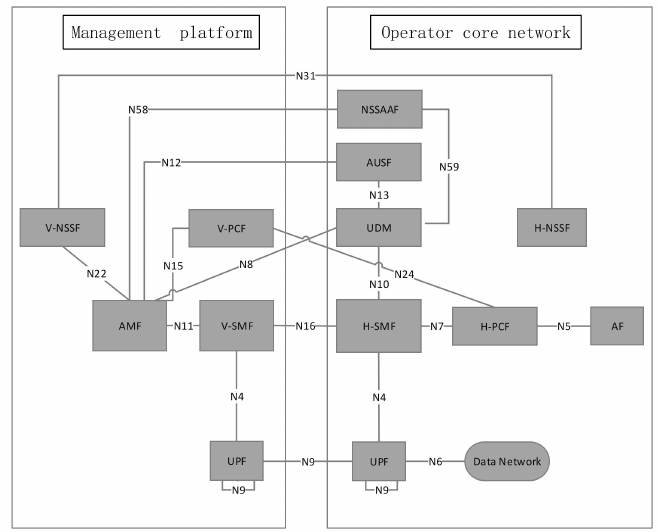
Figure 5. Interface of unified management platform and operator core